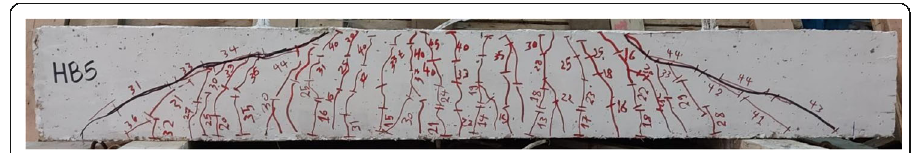
Fig. 11 Crack patterns at failure for shallow wide tested beam